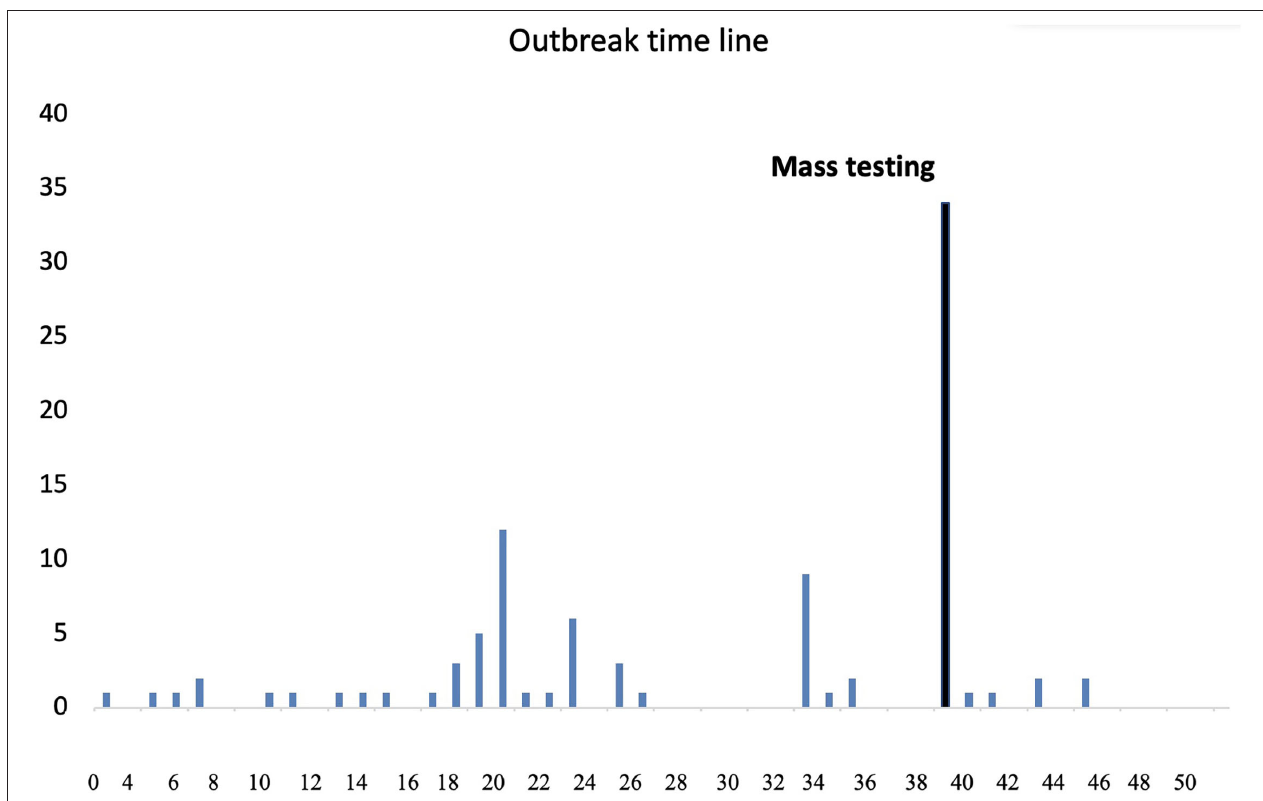
FIGURE 2 | Time of detection and numbers of PCR-positive workers over the course of a COVID-19 outbreak in a meat processing plant during 2020. Forty-two PCR-positive cases shown from day 38 arose from mass PCR-testing of all workers on site.